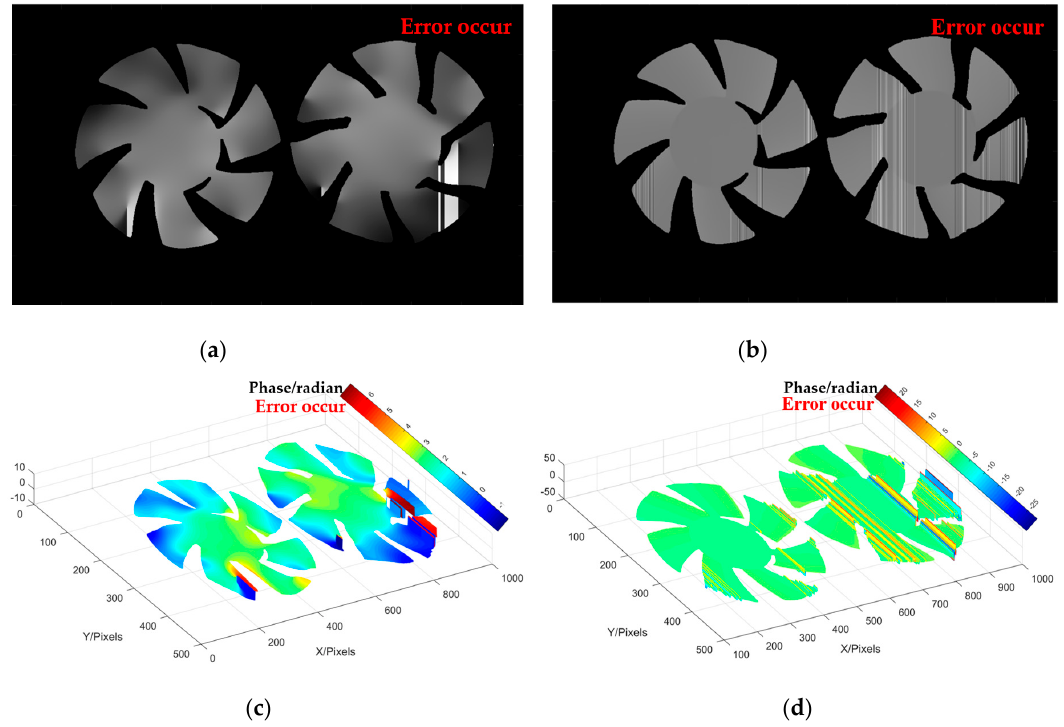
Figure 8. Comparative experiments about isolated object; ( a ) False unwrapped phase by FTP; ( b ) False unwrapped phase traditional TFTP; ( c ) Three-dimensional diagram of false unwrapped phase by FTP; ( d ) Three-dimensional diagram of false unwrapped phase traditional TFTP.